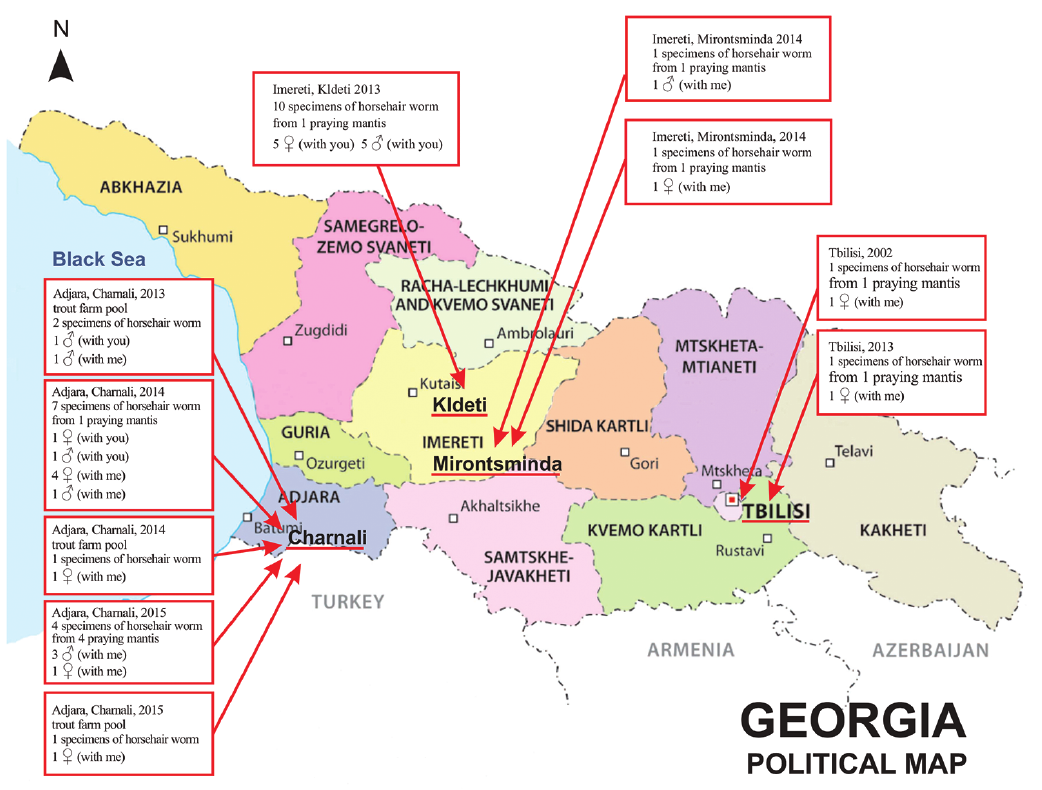
Figure 1. Distribution of Chordodes colchis in